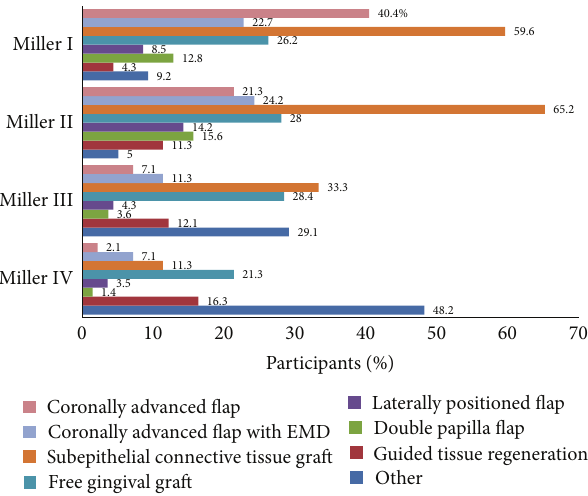
Figure 2: Participants’ responses: frequencies of the options for the treatment of Miller Class I–IV marginal tissue recession